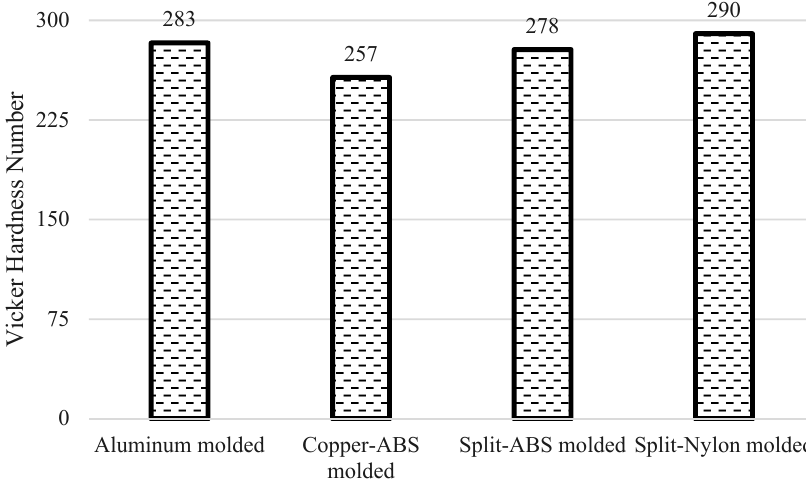
Figure 14. Hardness testing results for sintered parts.